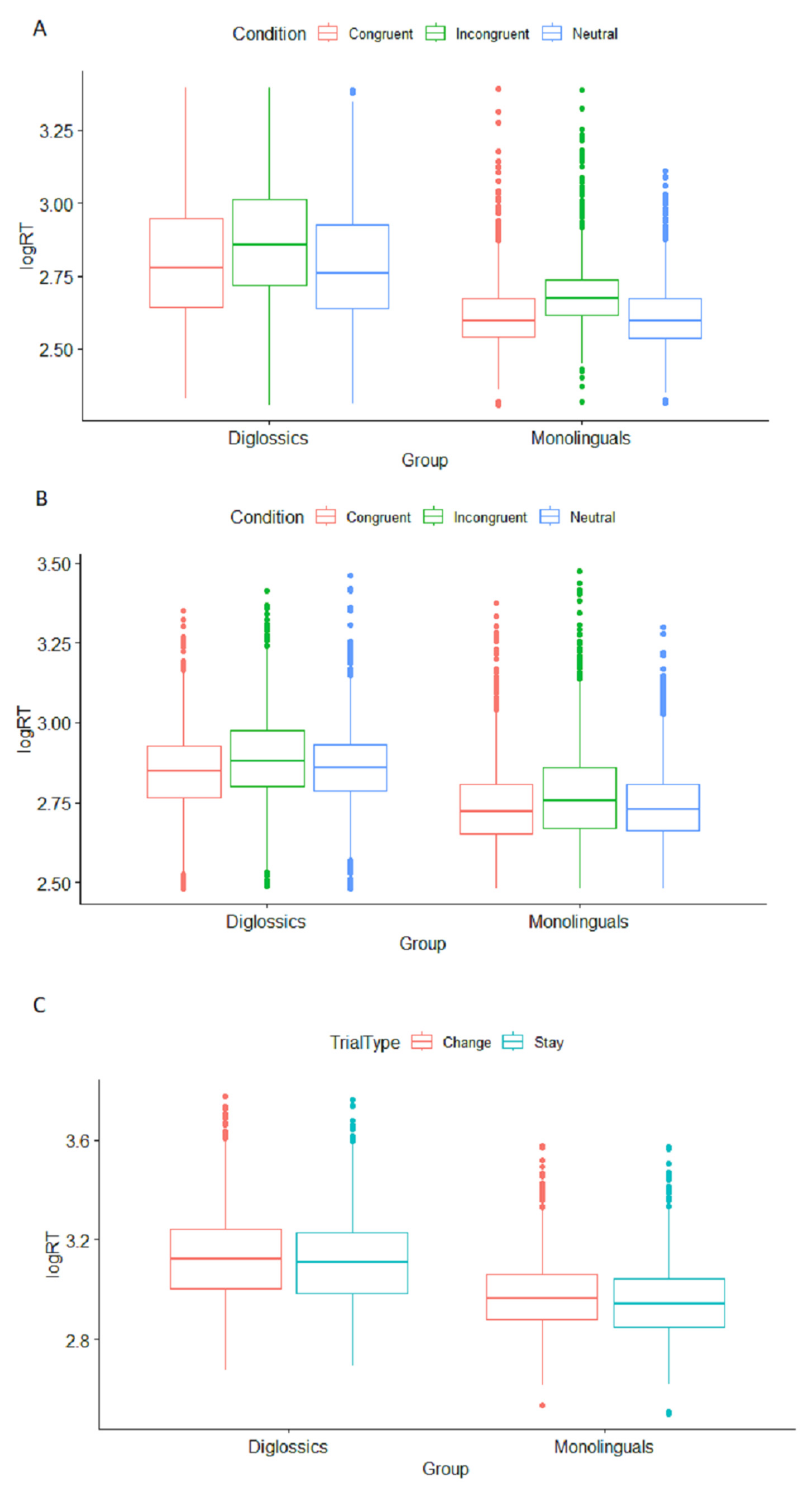
Figure 1. Reaction times for Diglossics and Monolinguals across conditions for ( A ) Flanker, ( B ) Stroop and ( C ) Color-shape tasks.